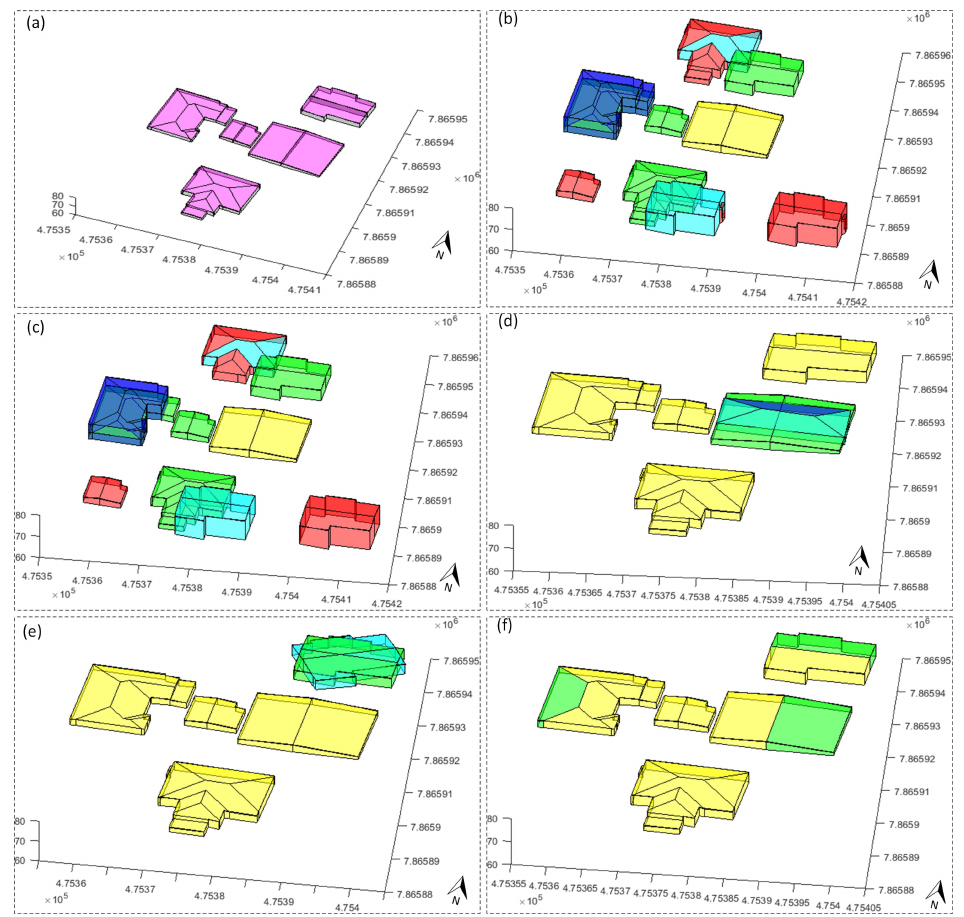
Figure 18. Selected qualitative results of Aitkenvale (AV) reference site after applying the proposed change detection method: ( a ) AV reference models; and change detections in test sites: ( b ) AV(17); ( c ) AV(26); ( d ) AV(29); ( e ) AV(30); and ( f ) AV(31) (Table 1). The reference models in ( a ) are shown in pink and grey colours. In the change detection results ( b – f ), the unchanged, new, modified, partially-modified and demolished planes are marked by yellow, red, blue, cyan and green colours,